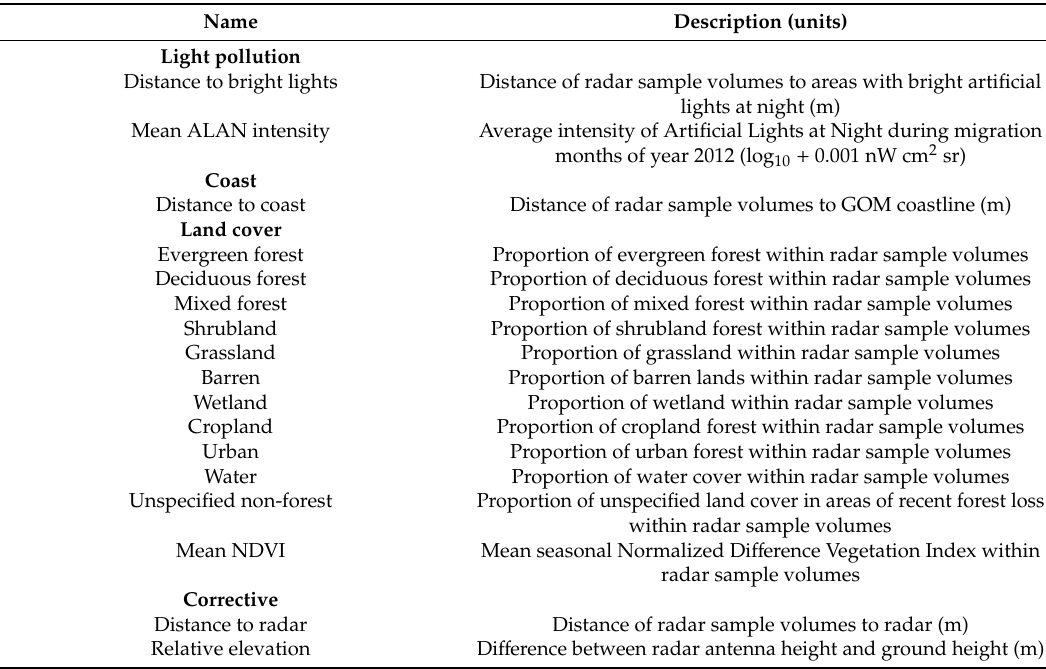
Table 1. Names and descriptions of model